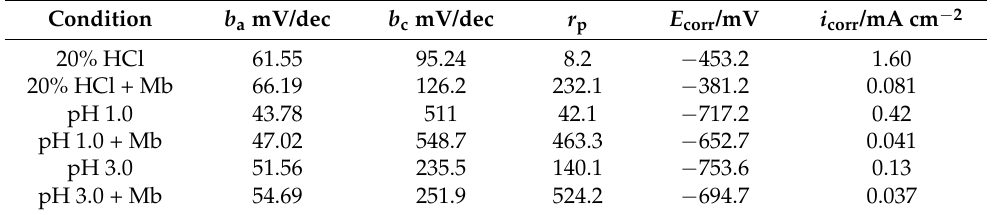
Table 1. The fitting results of potentiodynamic polarization curve parameters under different conditions.